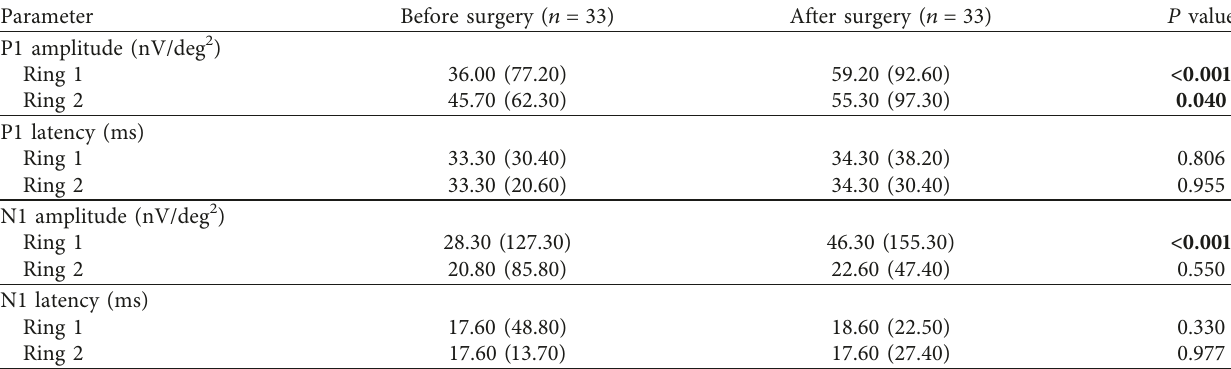
Table 1: Amplitude of P1 and N1 and respective latency times before and after surgery. Parameter Before surgery ( n � 33) After surgery ( n �